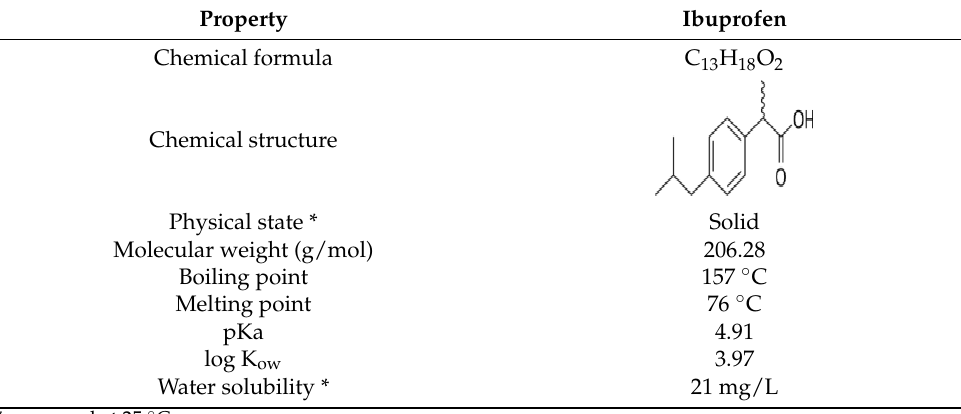
Table 1. Ibuprofen properties.